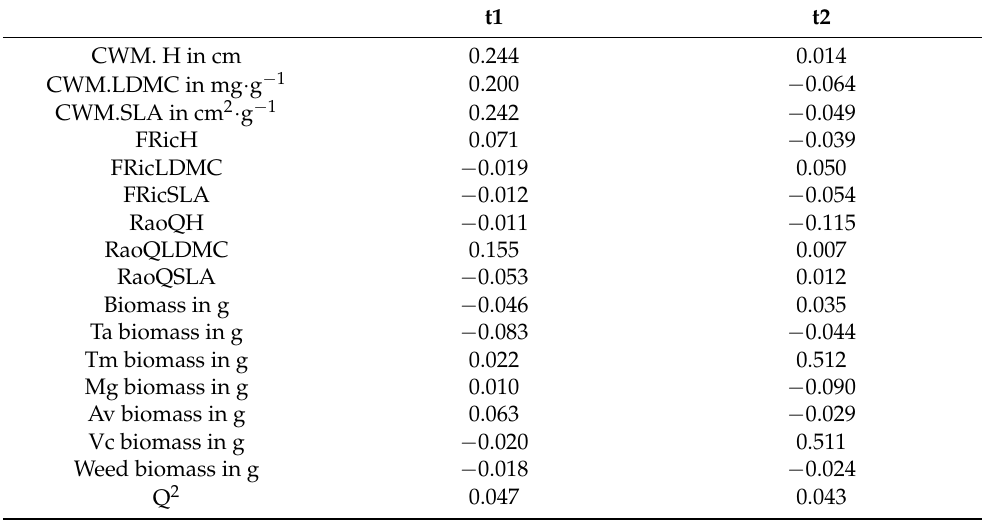
Table 5. Results of the PLS.Q 2 on the two first latent variables for the different vegetation descriptors. t1 t2 CWM. H in